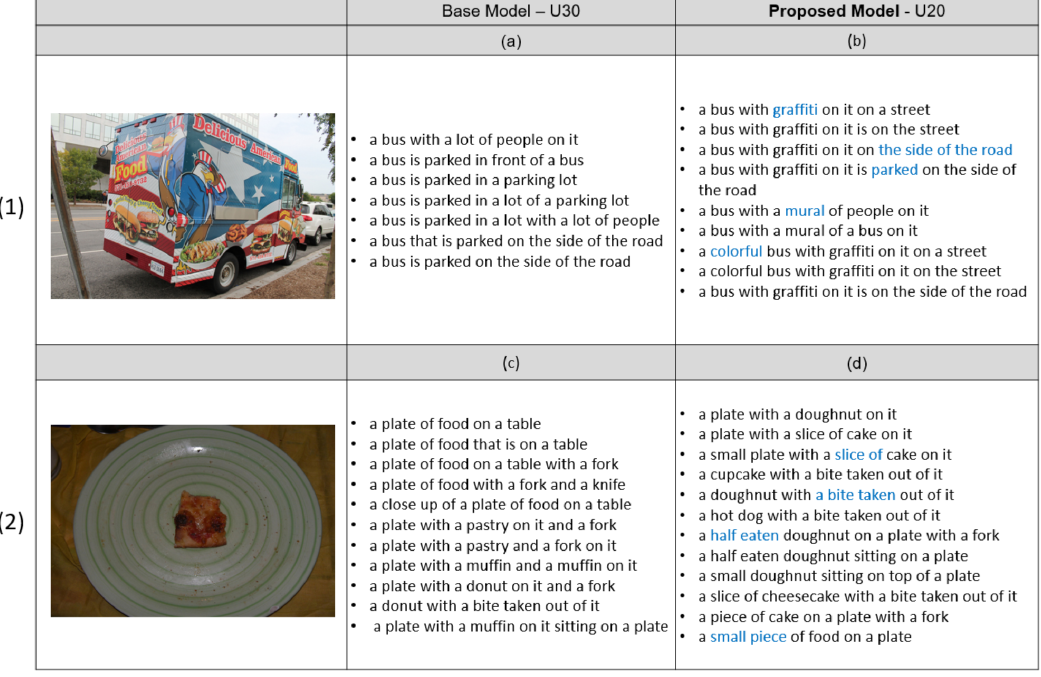
Figure 5. Comparison of the quality of multiple captions generated by the base model and the